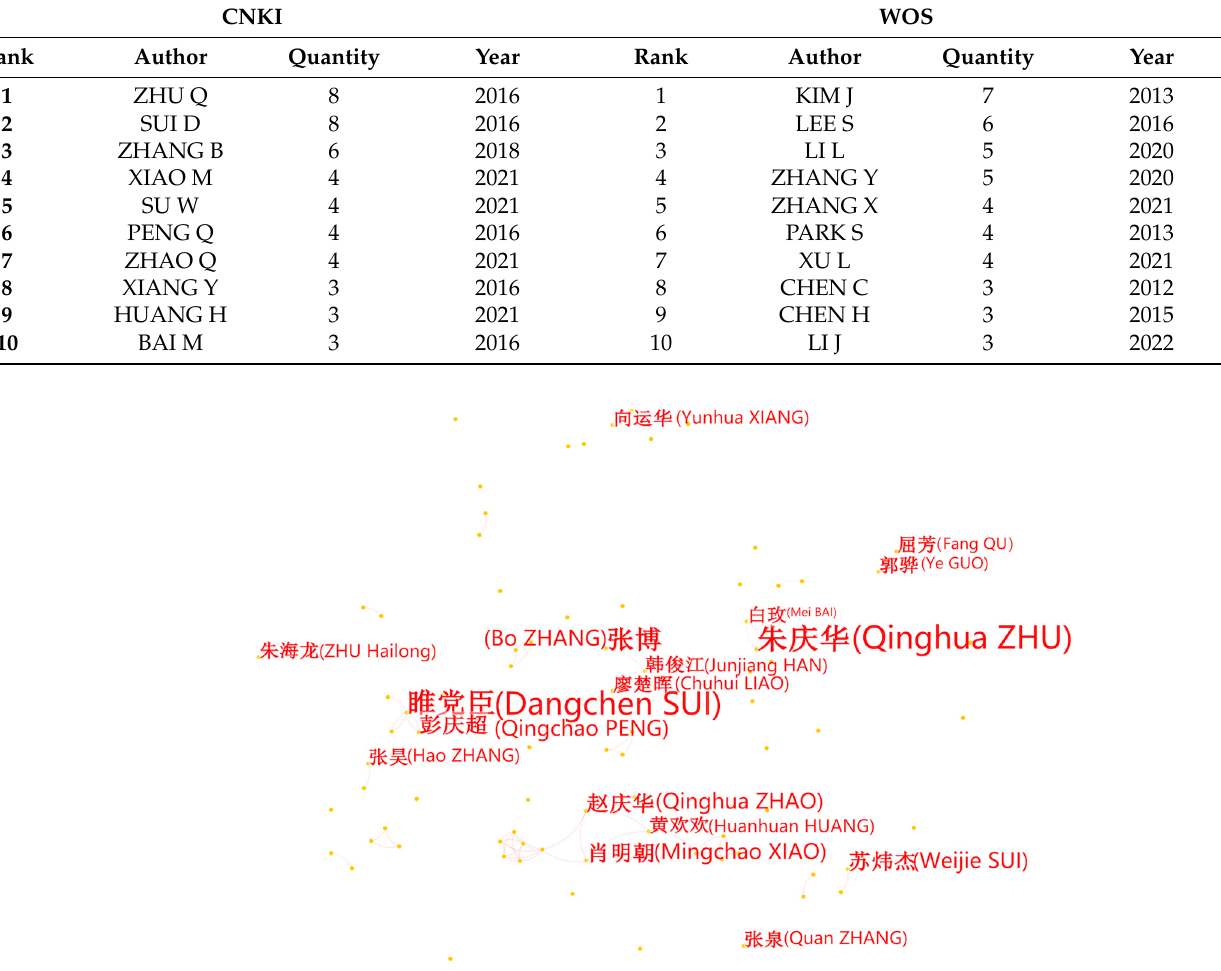
Figure 3. The author networks of studies from CNKI. (The contents in brackets are the translations of the original results which are presented in Chinese)